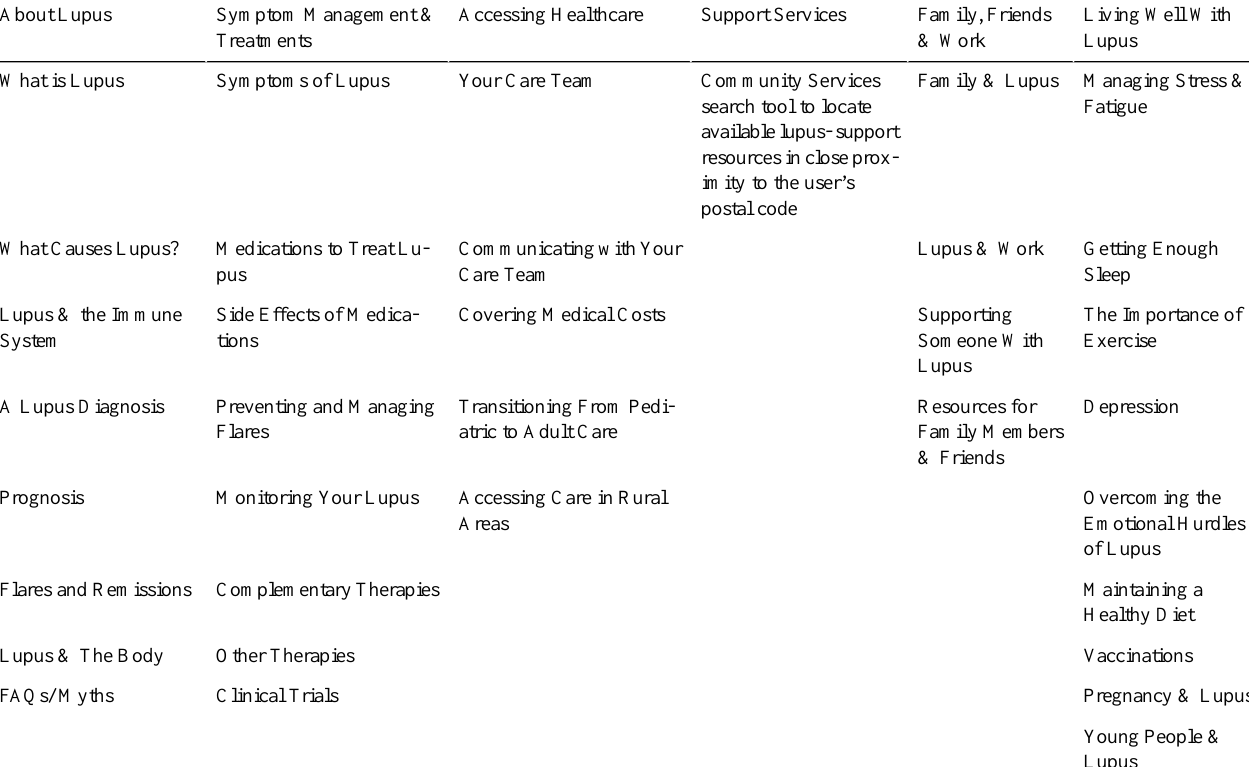
Table 1. Summary of LIN Table of Contents